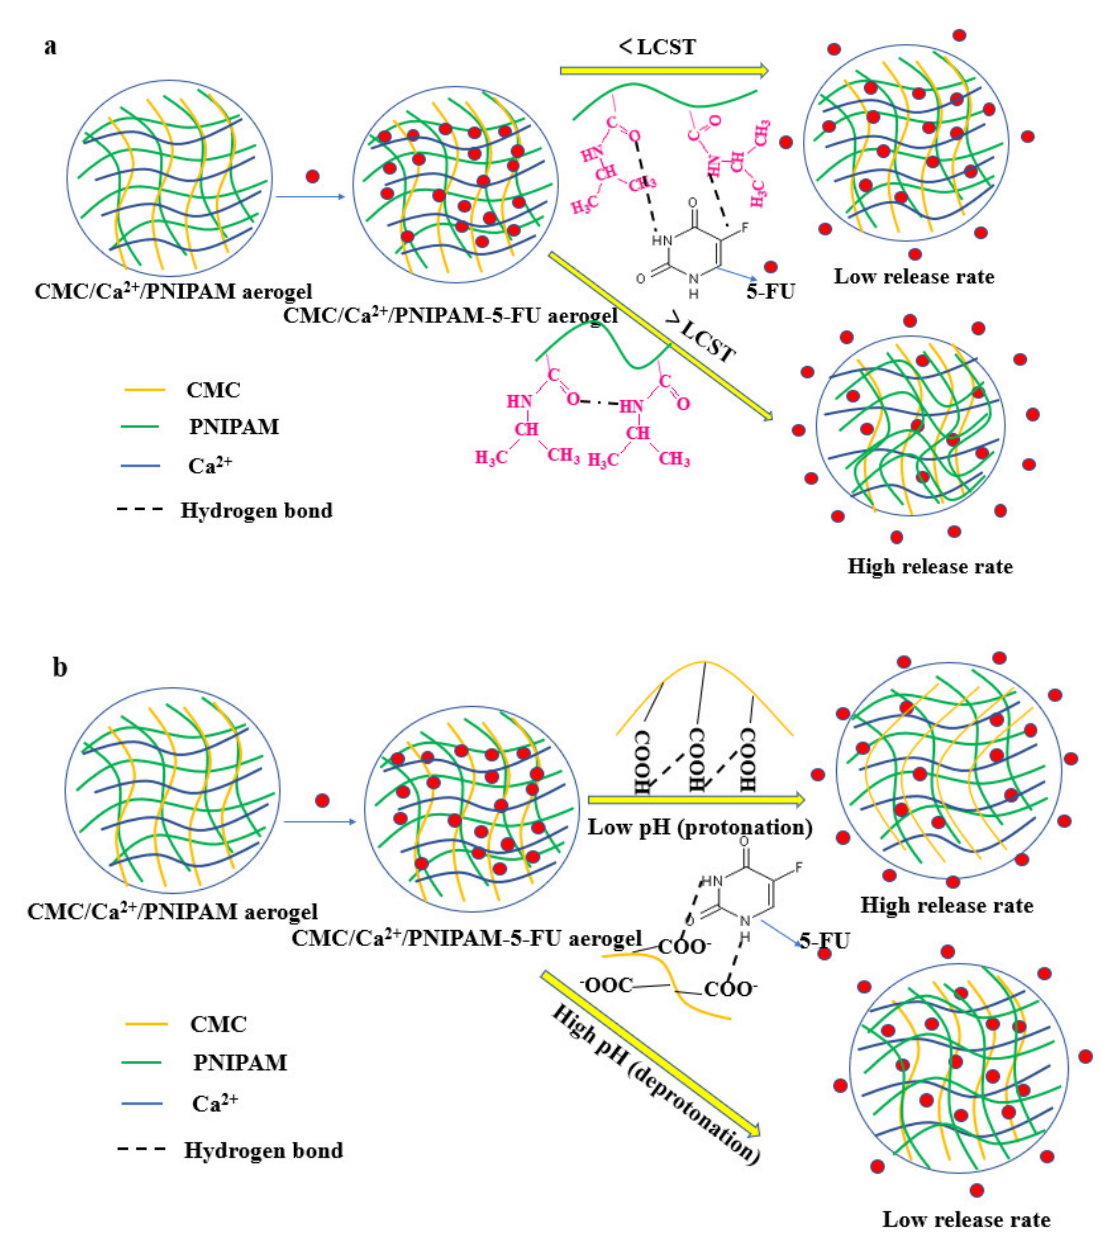
Figure 6. ( a ) Release process for aerogels under different temperatures; ( b ) release process for aerogels under different pH conditions.